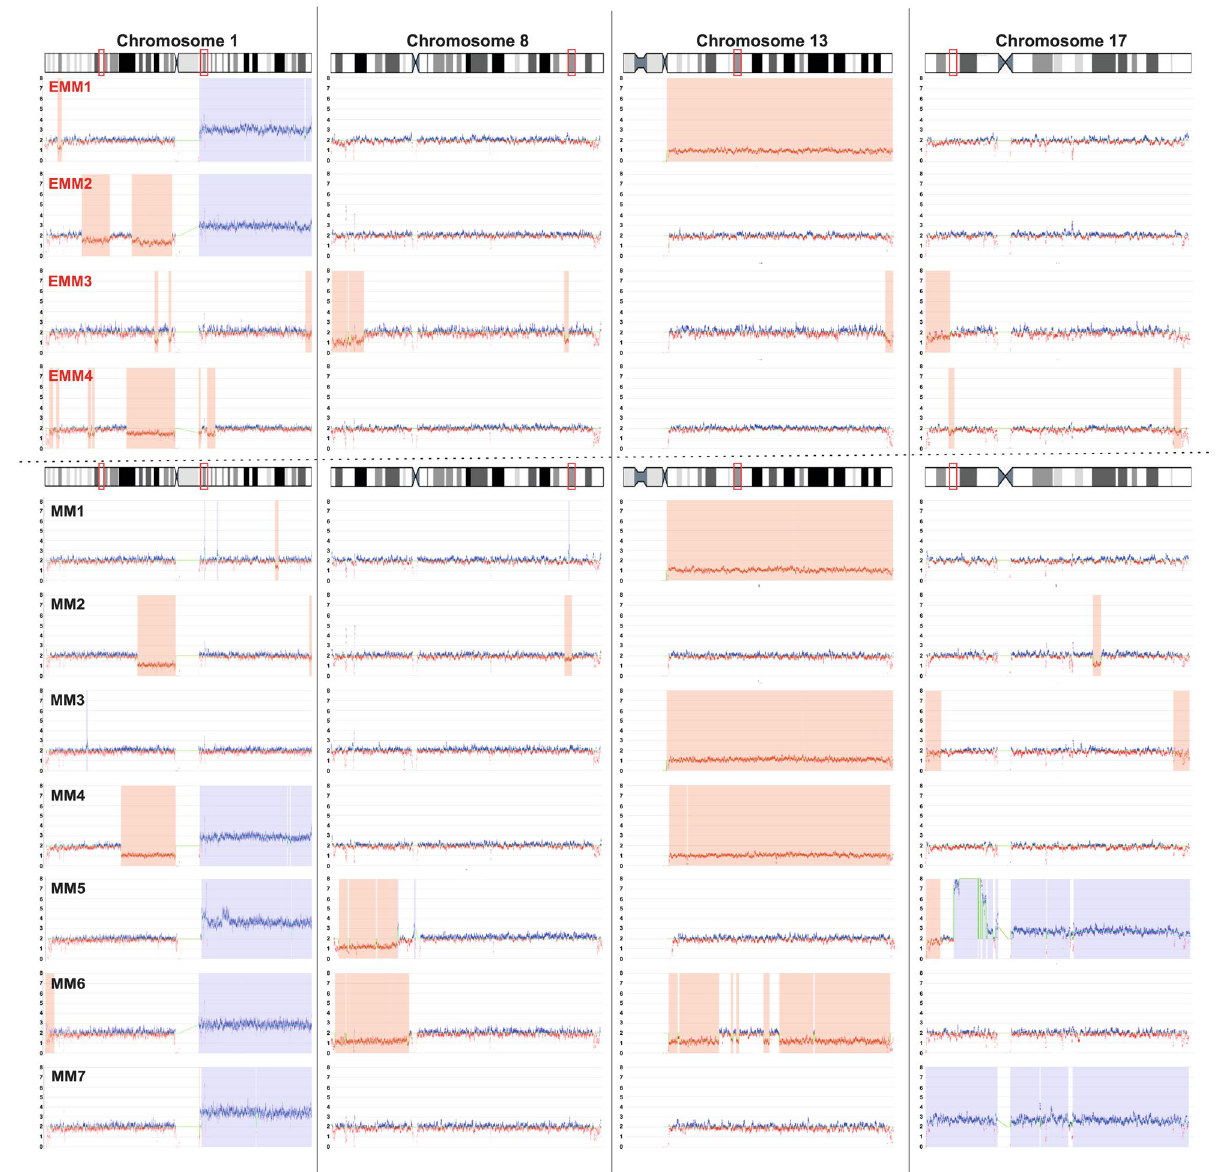
Figure 5. The genome CNVs on chromosomes 1, 8, 13 and 17 in EMM (upper part) and MM (lower part) patients. Blue indicates gains and red indicates losses in gene copy numbers. The vertical bars represent detected copy number aberrations. The red boxes on the ideogram highlight the high-risk